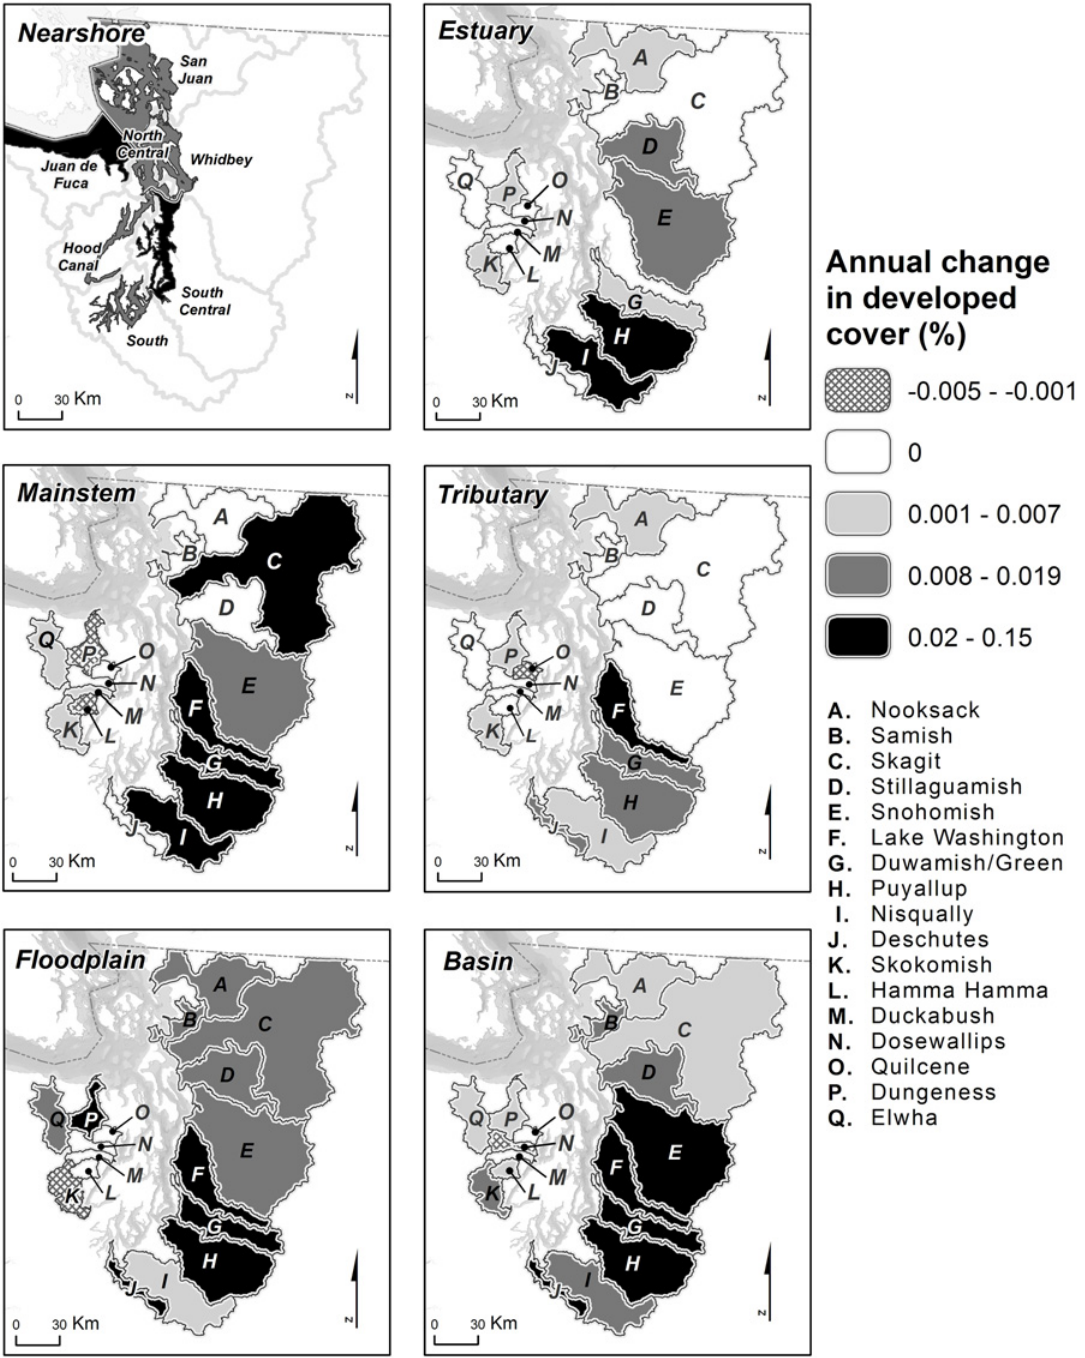
Fig 3. Annual Change in Developed Land Cover ( b 0 ): Watershed Scale. Annual rate of change in the percentage of developed land cover between 1986 and 2008 ( b 0 in Eq 1), summarized at the watershed scale for six habitat areas. Maps are shaded to depict the rate of change for a habitat area within a given watershed, but in each case the entire watershed is shaded to better visualize differences among watersheds. For the nearshore panel, the entire marine sub-region associated with each nearshore habitat area is shaded.